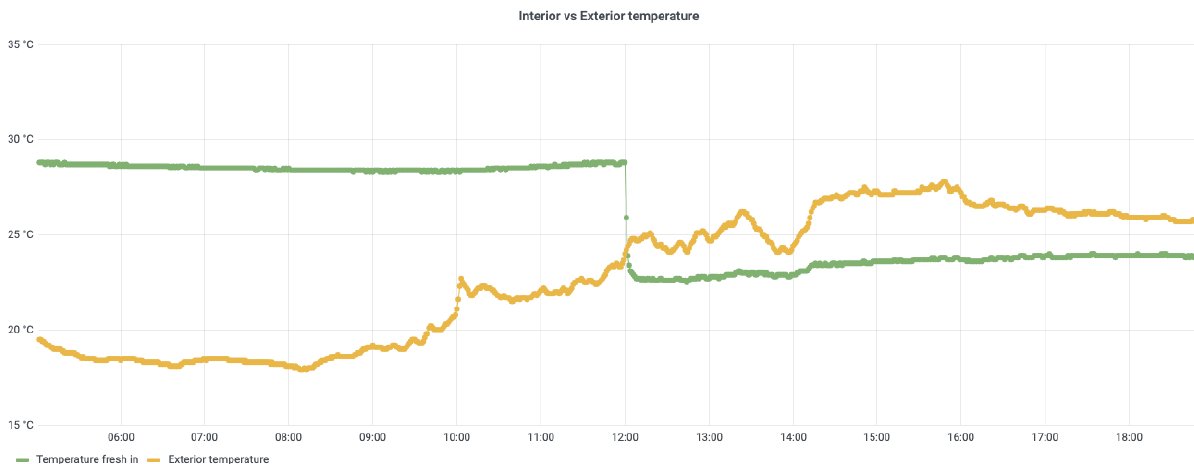
Figure 16. Interior vs. Exterior